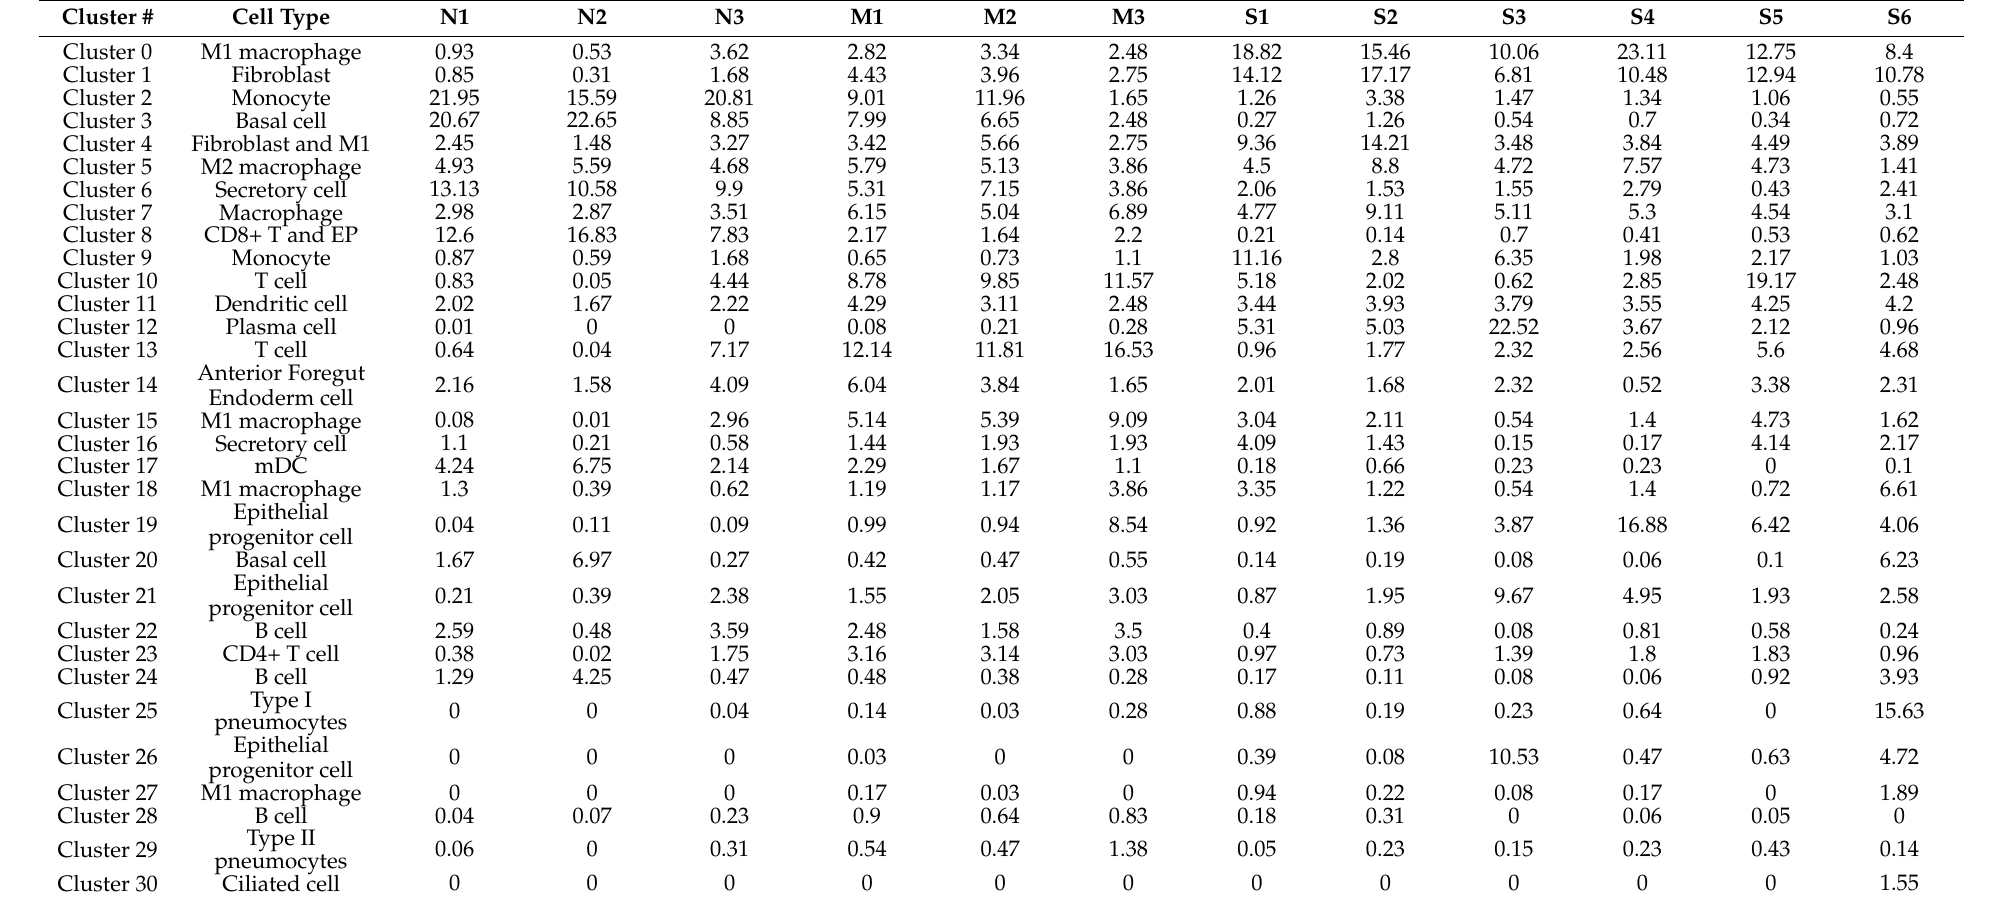
Table 2. The percentage of cells in each cluster for each patient. N, M, and S represent severity groups, respectively, while the number after the group represents the patient ID in the corresponding group; for example, N1 represents patient 1 in the normal group. Note: the summation of percentage in each column is 1, representing the cell composition of a sample (see also Figure